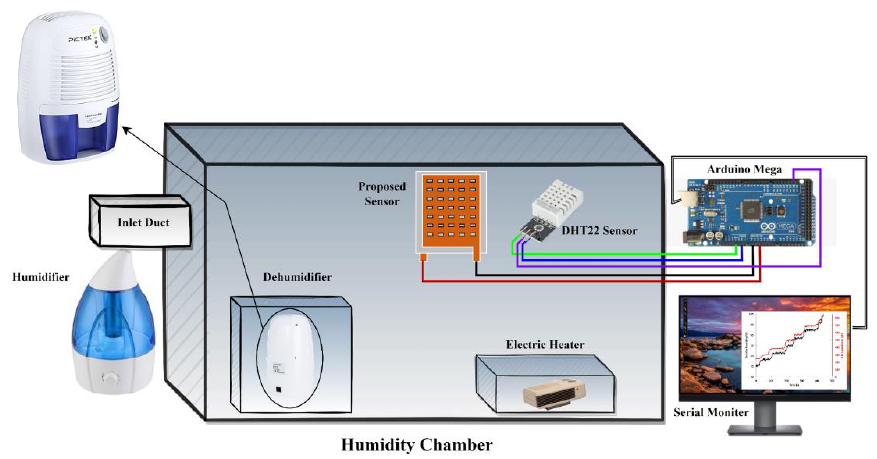
Figure 4. Experimental setup for measurement of humidity.